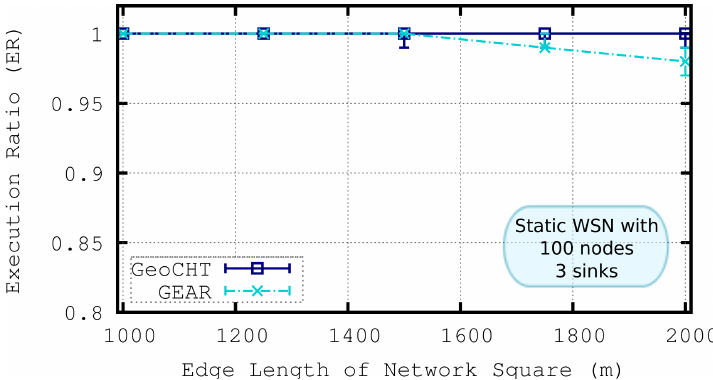
Figure 7. Execution Ratio of GeoCHT and GEAR in a static